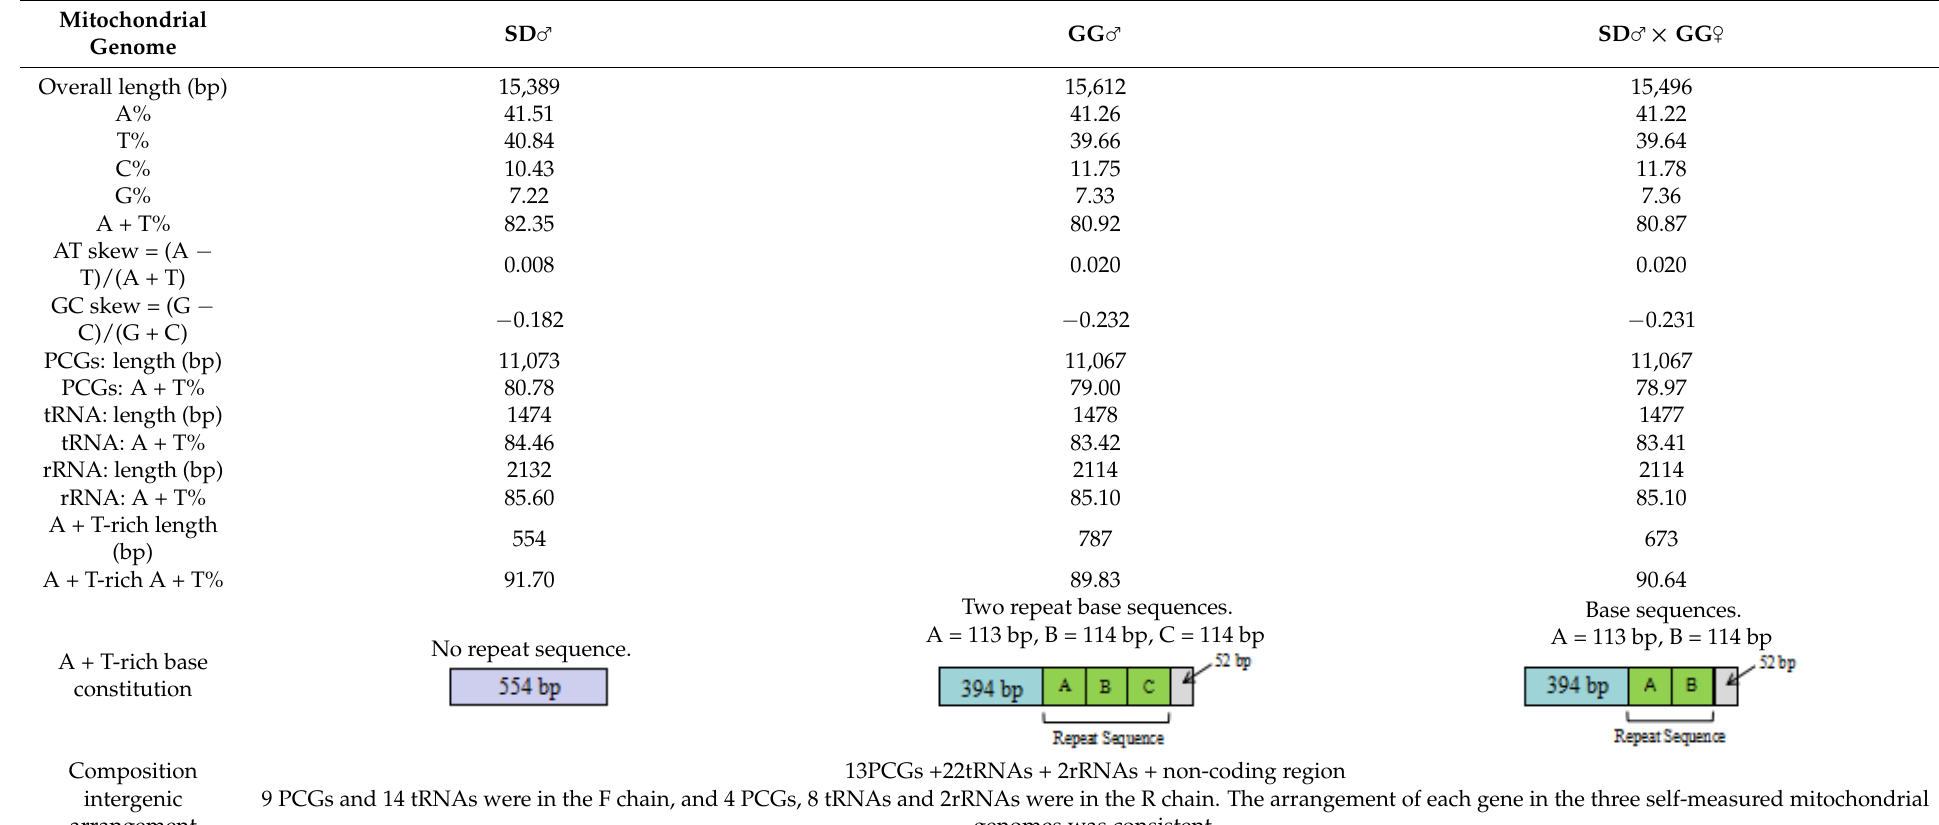
Table 2. Comparison of the complete mitochondrial genomes of three Thitarodes